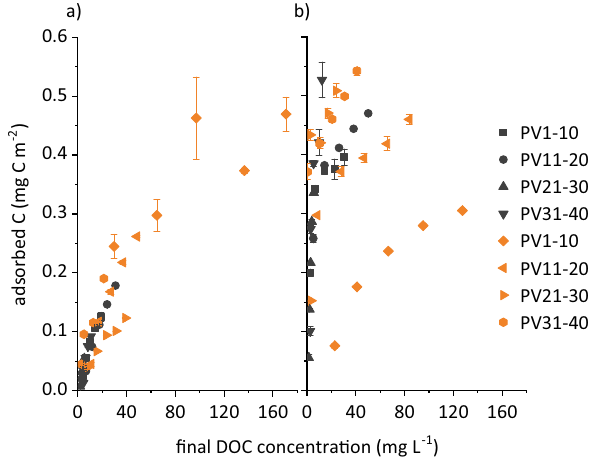
Figure 5. Adsorbed C related to the specific surface area of ( a ) Al-montmorillonite and ( b ) goethite against the final DOC concentration of composite solutions from release experiments at q = 1 mm h −1 (orange, slow run) and q = 10 mm h −1 (black, fast run). Error bars represent standard errors of